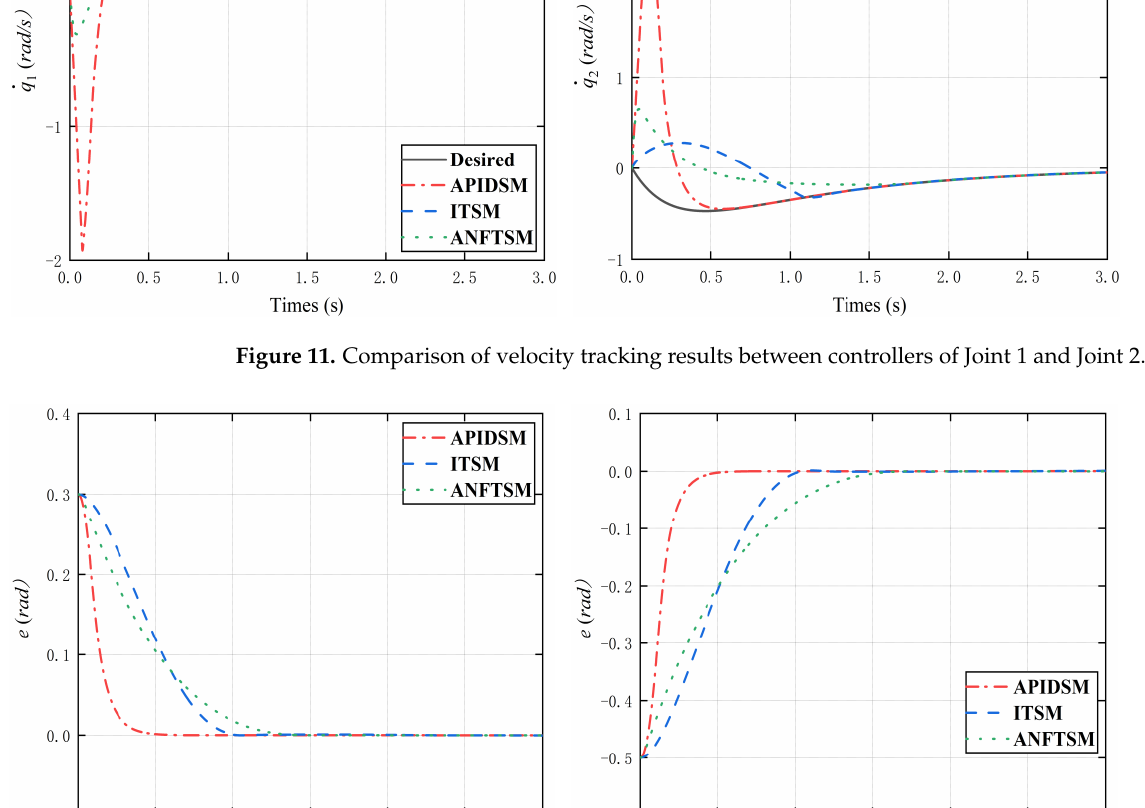
Figure 13. Comparison of input torque results between controllers of Joint 1 and Joint 2. To obtain the compared results more clearly, the integration of the absolute value of the error (IAE) and the integral of the time multiplied by the absolute value of the error (ITAE) were introduced for quantitative analysis [34]. Table 3 shows the comparison re- sults between the performance indicators IAE and ITAE. These are defined as follows: 𝐼𝐴𝐸 = ∫ |𝑒 1 |𝑑𝑡 𝑡 𝑓 0